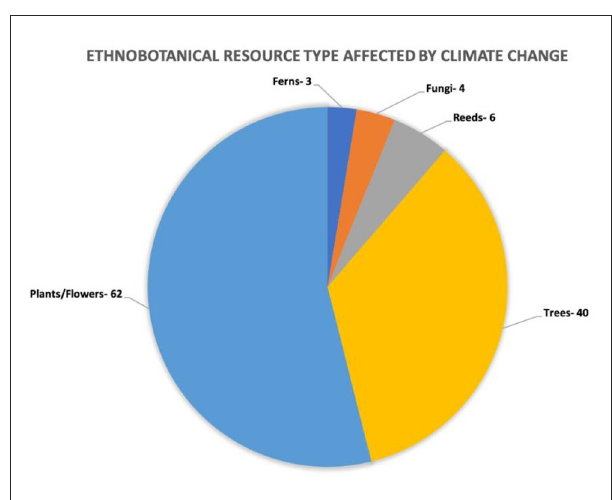
Maple trees are culturally central to Odawa people, who used the sap in the spring for food and medicine. Maple wood is used for crafts